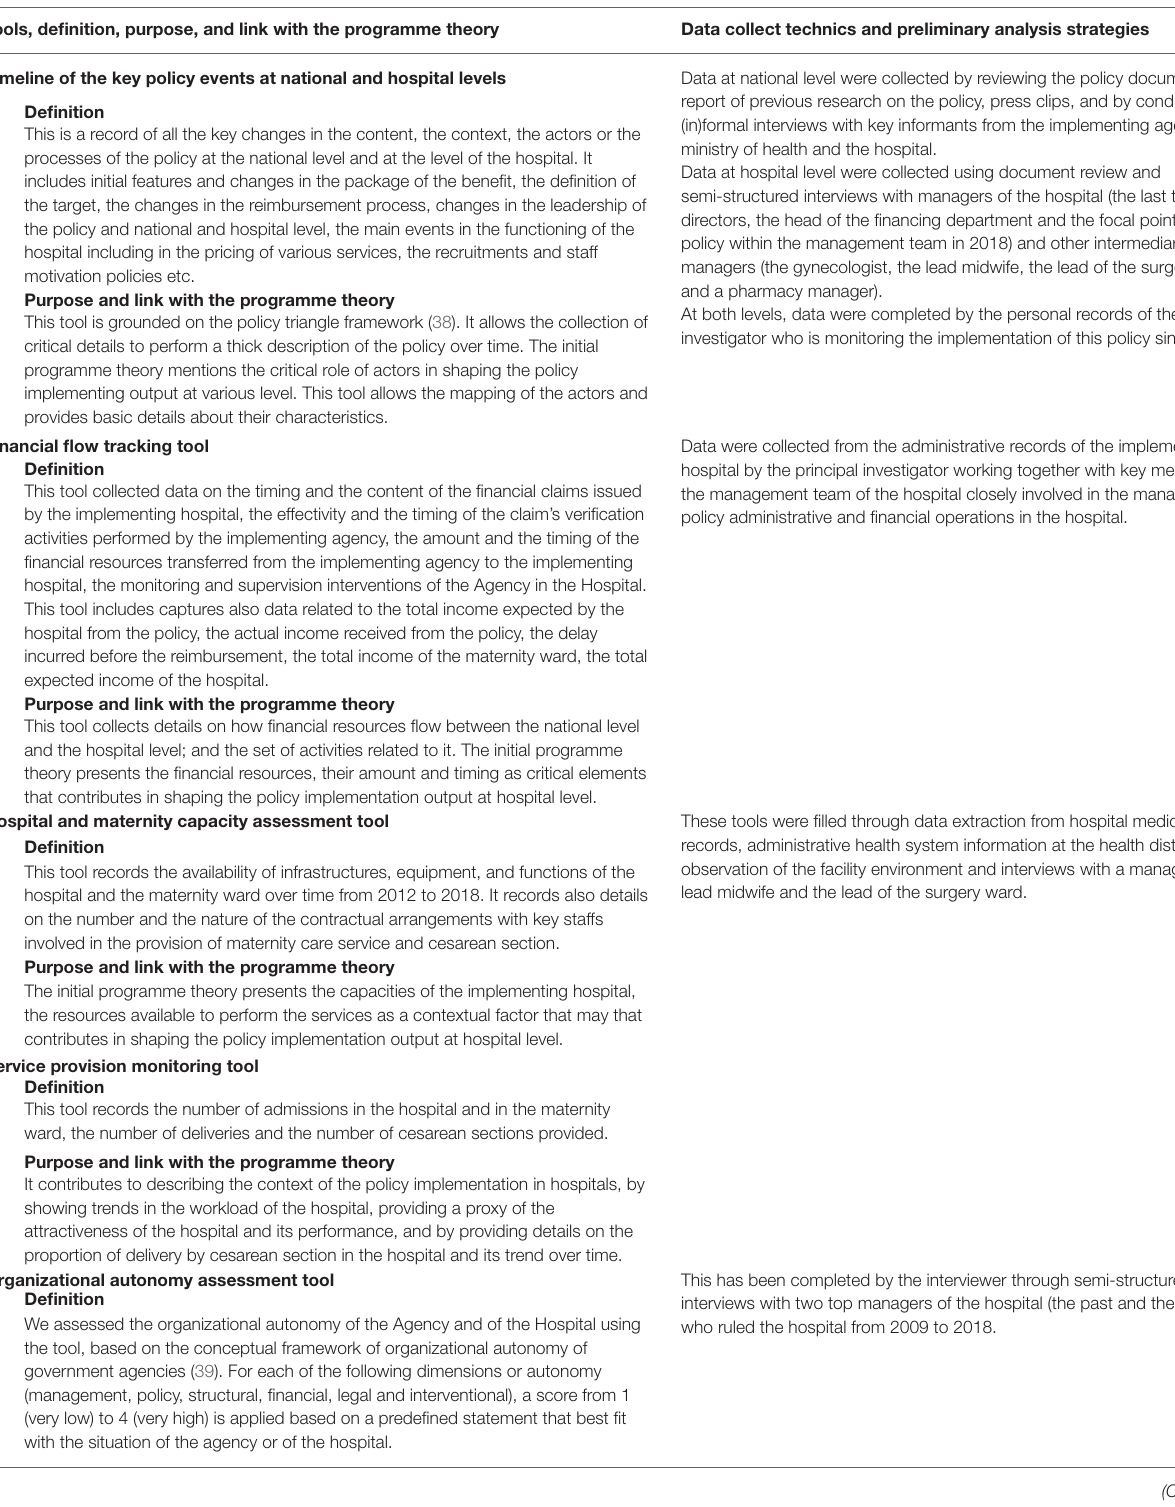
TABLE 3 | Tools to describe the policy in its context: definition, purpose, link with the programme theory, data collect technics, and preliminary analysis